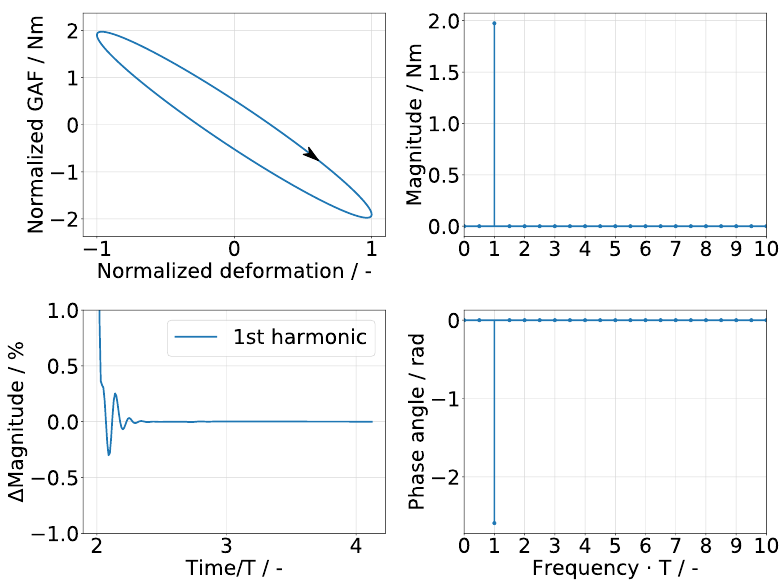
Figure 4. Analysis approach of generalized aerodynamic response